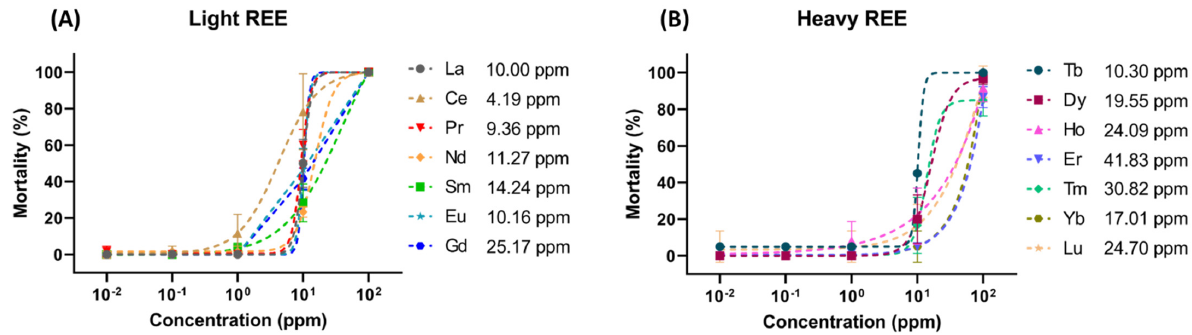
Figure 1. LC 50 of zebrafish embryos exposed to actual concentrations (ppm) of ( A ) Lanthanide’s light REE and ( B ) Lanthanide’s heavy REE for 96 h. The 96 h LC50 values were calculated by using the sigmoid curve fitting method and the data are expressed as mean ± SEM.